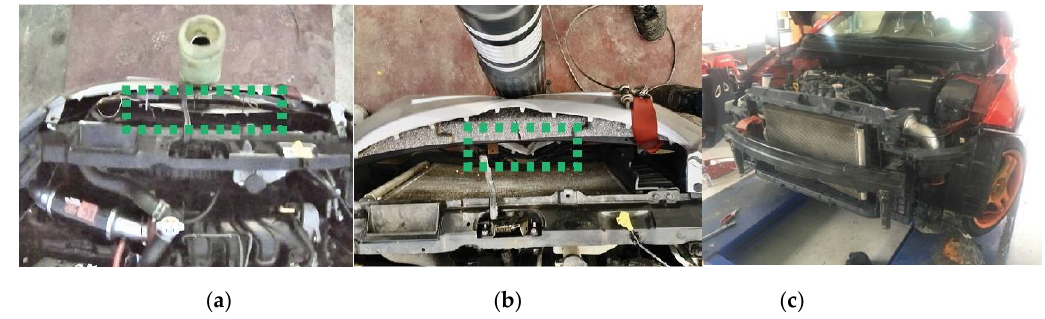
Figure 20. Result of collision with steel bollard: ( a ) Collision with honeycomb bollard; ( b ) Collision with steel bollard; ( c ) Disassembled vehicle after collision with steel bollard.